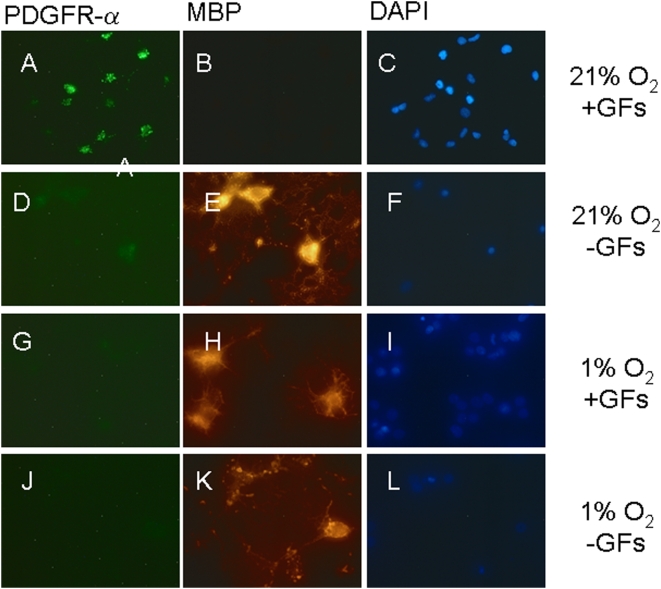
Hypoxia induces premature OL maturation.Images of OLs cultured for one week in 21% O2 in the presence (A–C) or absence (D–F) of GFs, or in 1% O2 with (G–I) or without (J–L) GFs. Cells were double-labeled for PDGFRα (A, D, G, J) or MBP (B, E, H, K) and counterstained with DAPI (C, F, I, L). A higher proportion of cells stained for PDGFRα (green) in 21% O2 whereas more MBP (red) labeled cells were observed in 1% O2 plus GF, or in GF-deprived cultures. OL differentiation was assessed from numbers of MBP-positive cells relative to total cell number (DAPI-positive nuclei). (* p<0.001 in comparison to cultures treated with GFs and maintained at 21% O2). Scale bars = 10 µm. Data shown are representative of three separate studies. At least ten separate coverslips were analyzed per study.